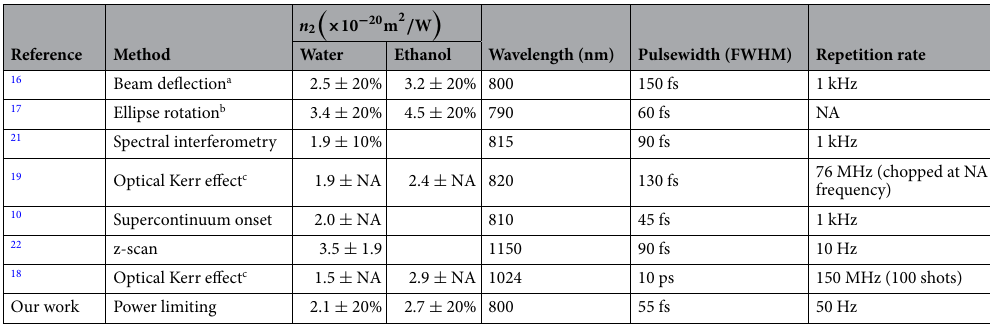
Table 1. Evaluation of the Kerr nonlinear index of refraction of deionized water and ethanol: a comparison between values in the literature and our measurement. NA non available. a Only the electronic n 2 obtained in 16 is considered. b Larger pulsewidths are examined in 17 , however, only the smallest value is considered here, to exclude slower contributions on the value of n 2 . c The value of n 2 in 18,19 is given in 10 − 13 esu, thus we have ( 3 ) ( esu ) = n 0 n 2 ( esu )/( 8 π) and converted in m 2 / W 2 by applying the relation calculated χ 1111 = / (cid:29) n 2 χ ( 3 ) ( esu ) (cid:28) 20 n 2 m 2 / W 3.95 × 10 − 6 0 1111 (cid:31) (cid:30) (cid:31) (cid:30)